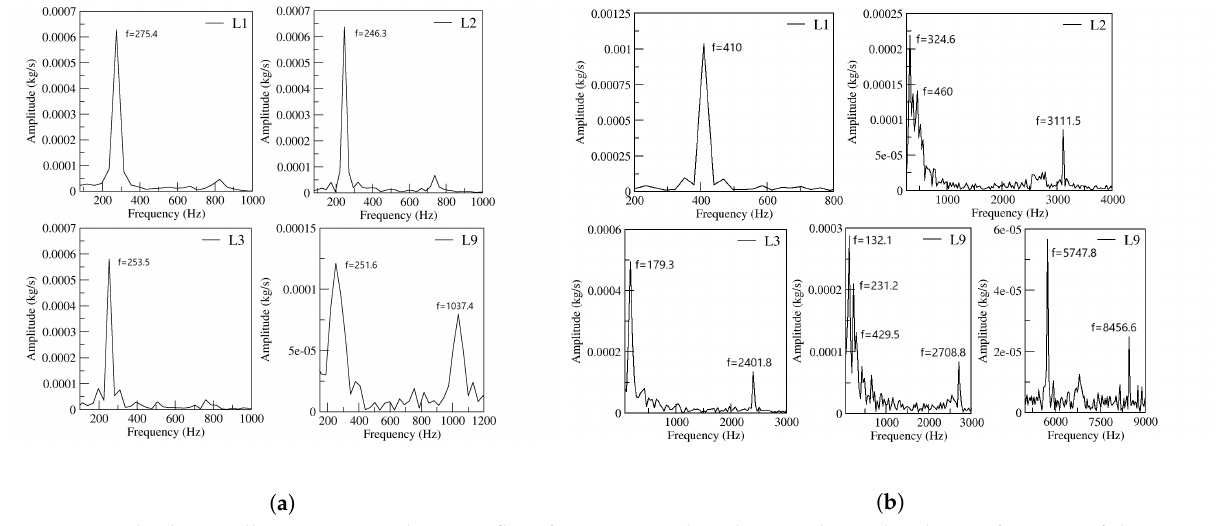
Figure 10. Fluidic Oscillator upper outlet mass flow frequency and peak-to-peak amplitude as a function of the power nozzle velocity and the feedback channel length. ( a ) Power nozzle velocity, 65 m/s. ( b ) Power nozzle velocity, 97 m/s.